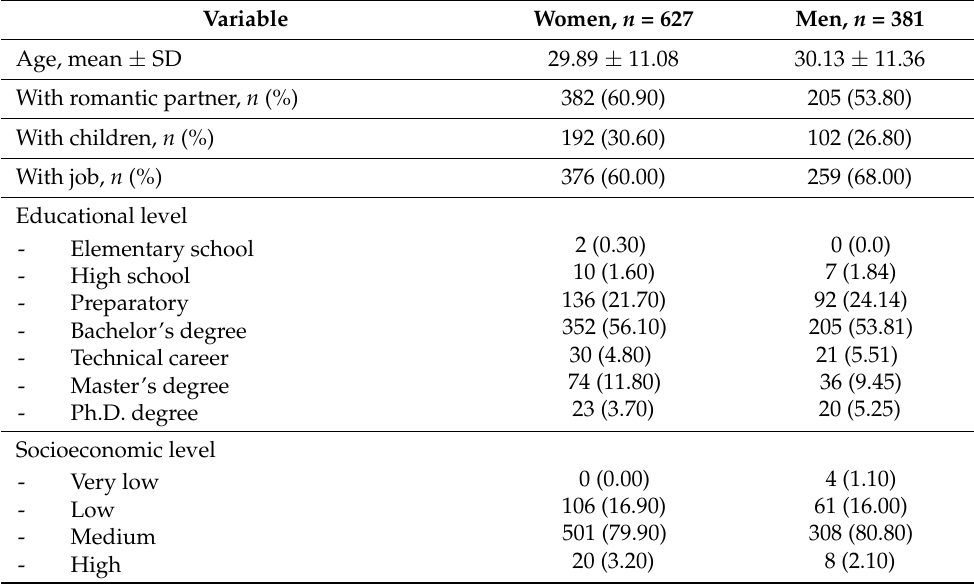
Table 1. Sociodemographic variables in the studied population.